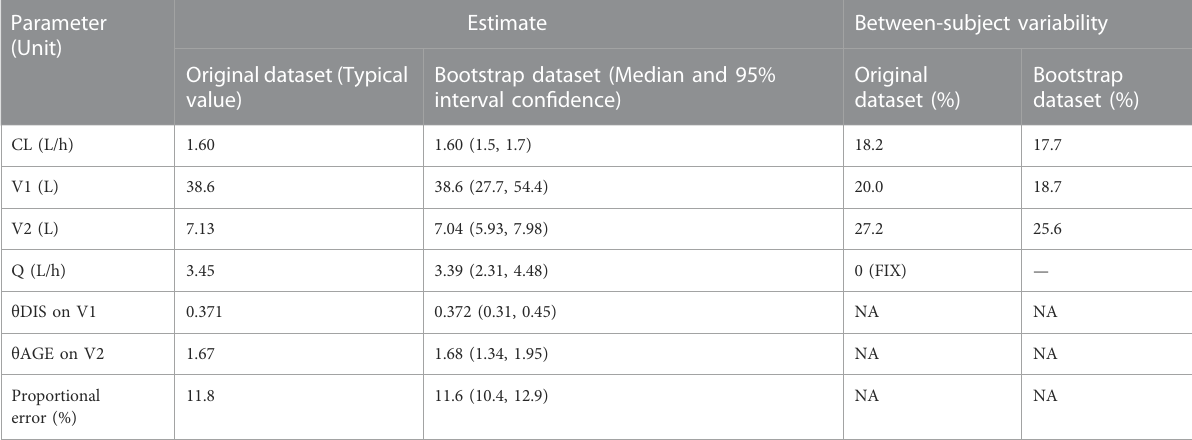
TABLE 5 Population pharmacokinetic parameter estimates and between-subject